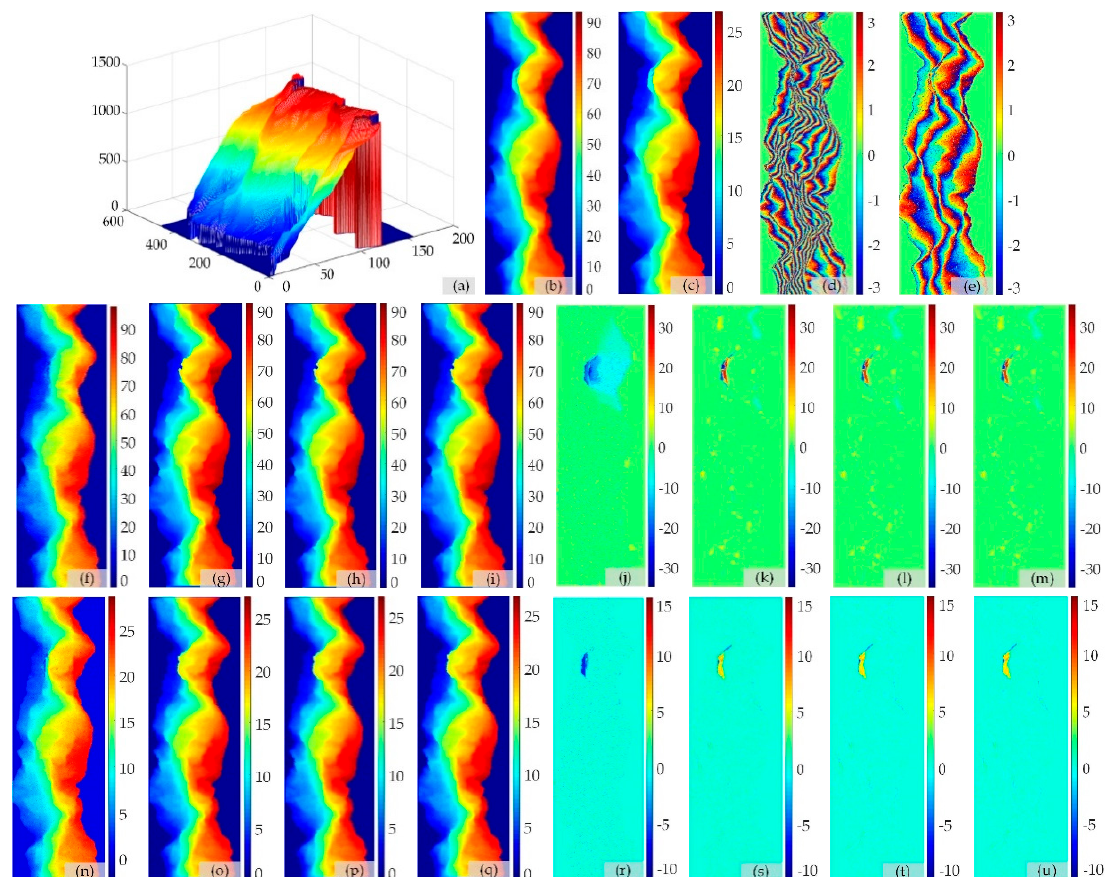
Figure 3. ( a ) Digital elevation model (DEM) for simulation data (unit: m). ( b,c ) Reference unwrapped phases (( b ) long and ( c ) short baseline length). ( d,e ) Simulated wrapped phases of ( b,c ). ( f–i ) PU results of ( b ) obtained by ( f ) TSPA, ( g ) extended Kalman filter (TSPAEKF), ( h ) cubature Kalman filter